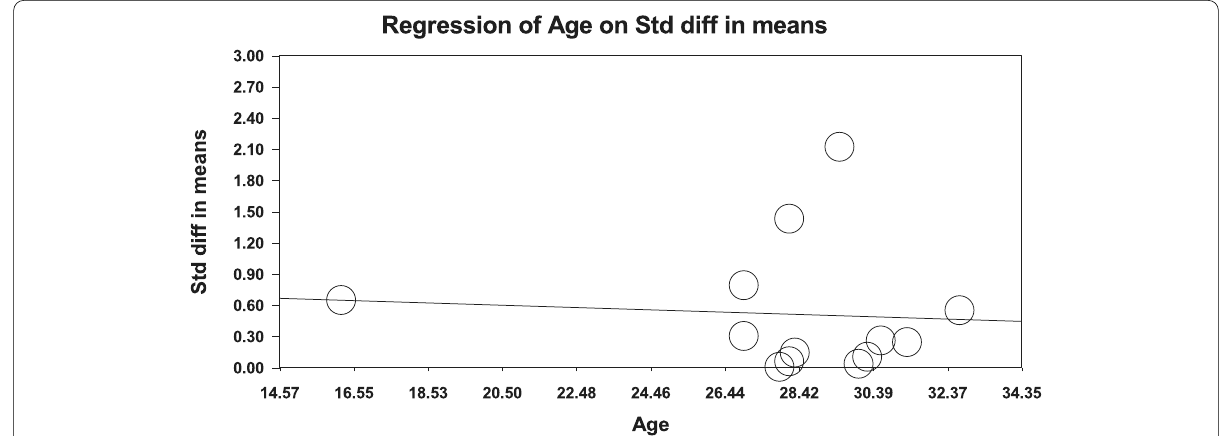
Fig. 8 The meta-regression of the relationship between mean age and SMD of AMH before and after the intervention in the control and intervention groups